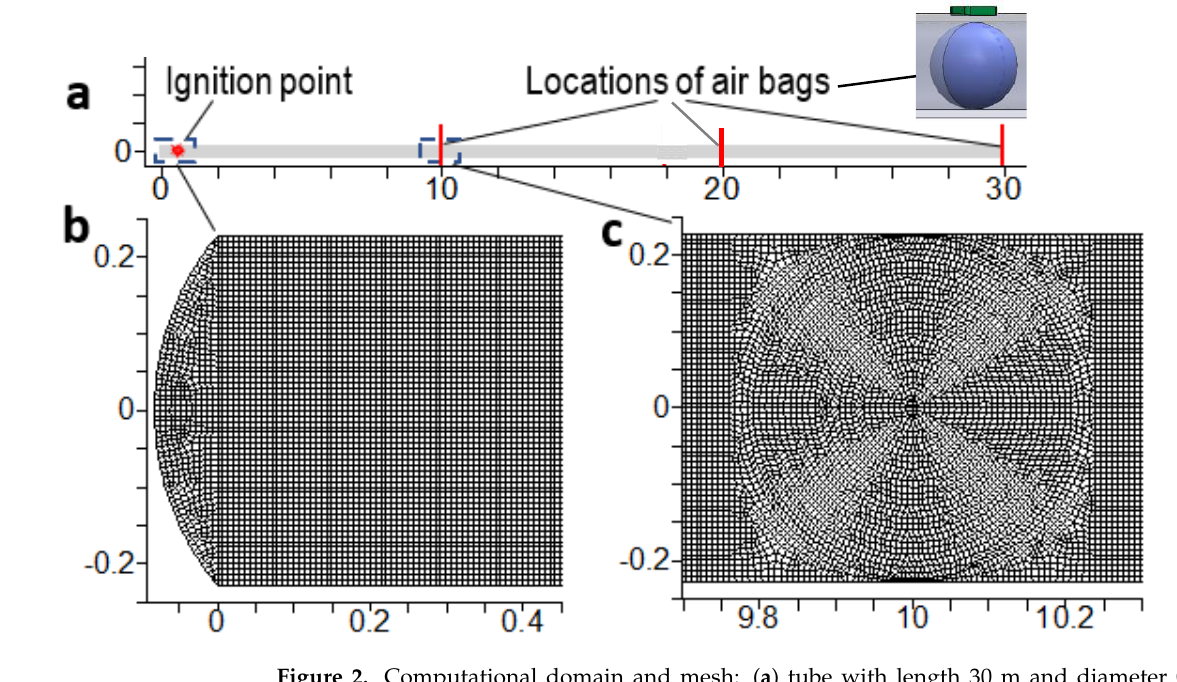
Figure 2. Computational domain and mesh: ( a ) tube with length 30 m and diameter 0.456 m; ( b ) computational mesh in the marked region at the head of the tube; and ( c ) computational mesh at the location where an obstruction is installed. Ignition point is set at a location 0.277 m far away from the tip of the dome.